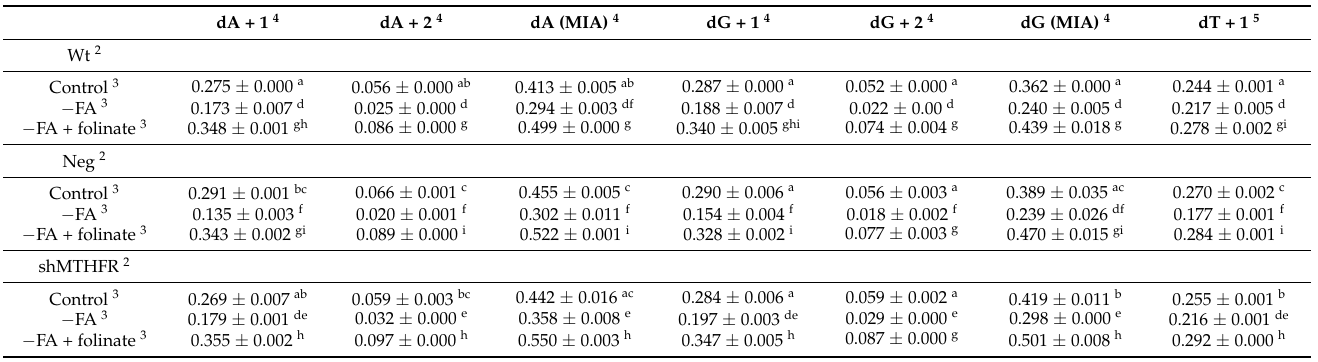
Table 5. MTHFR knockdown assisted nucleotide biosynthesis in HepG2 cells 1,2